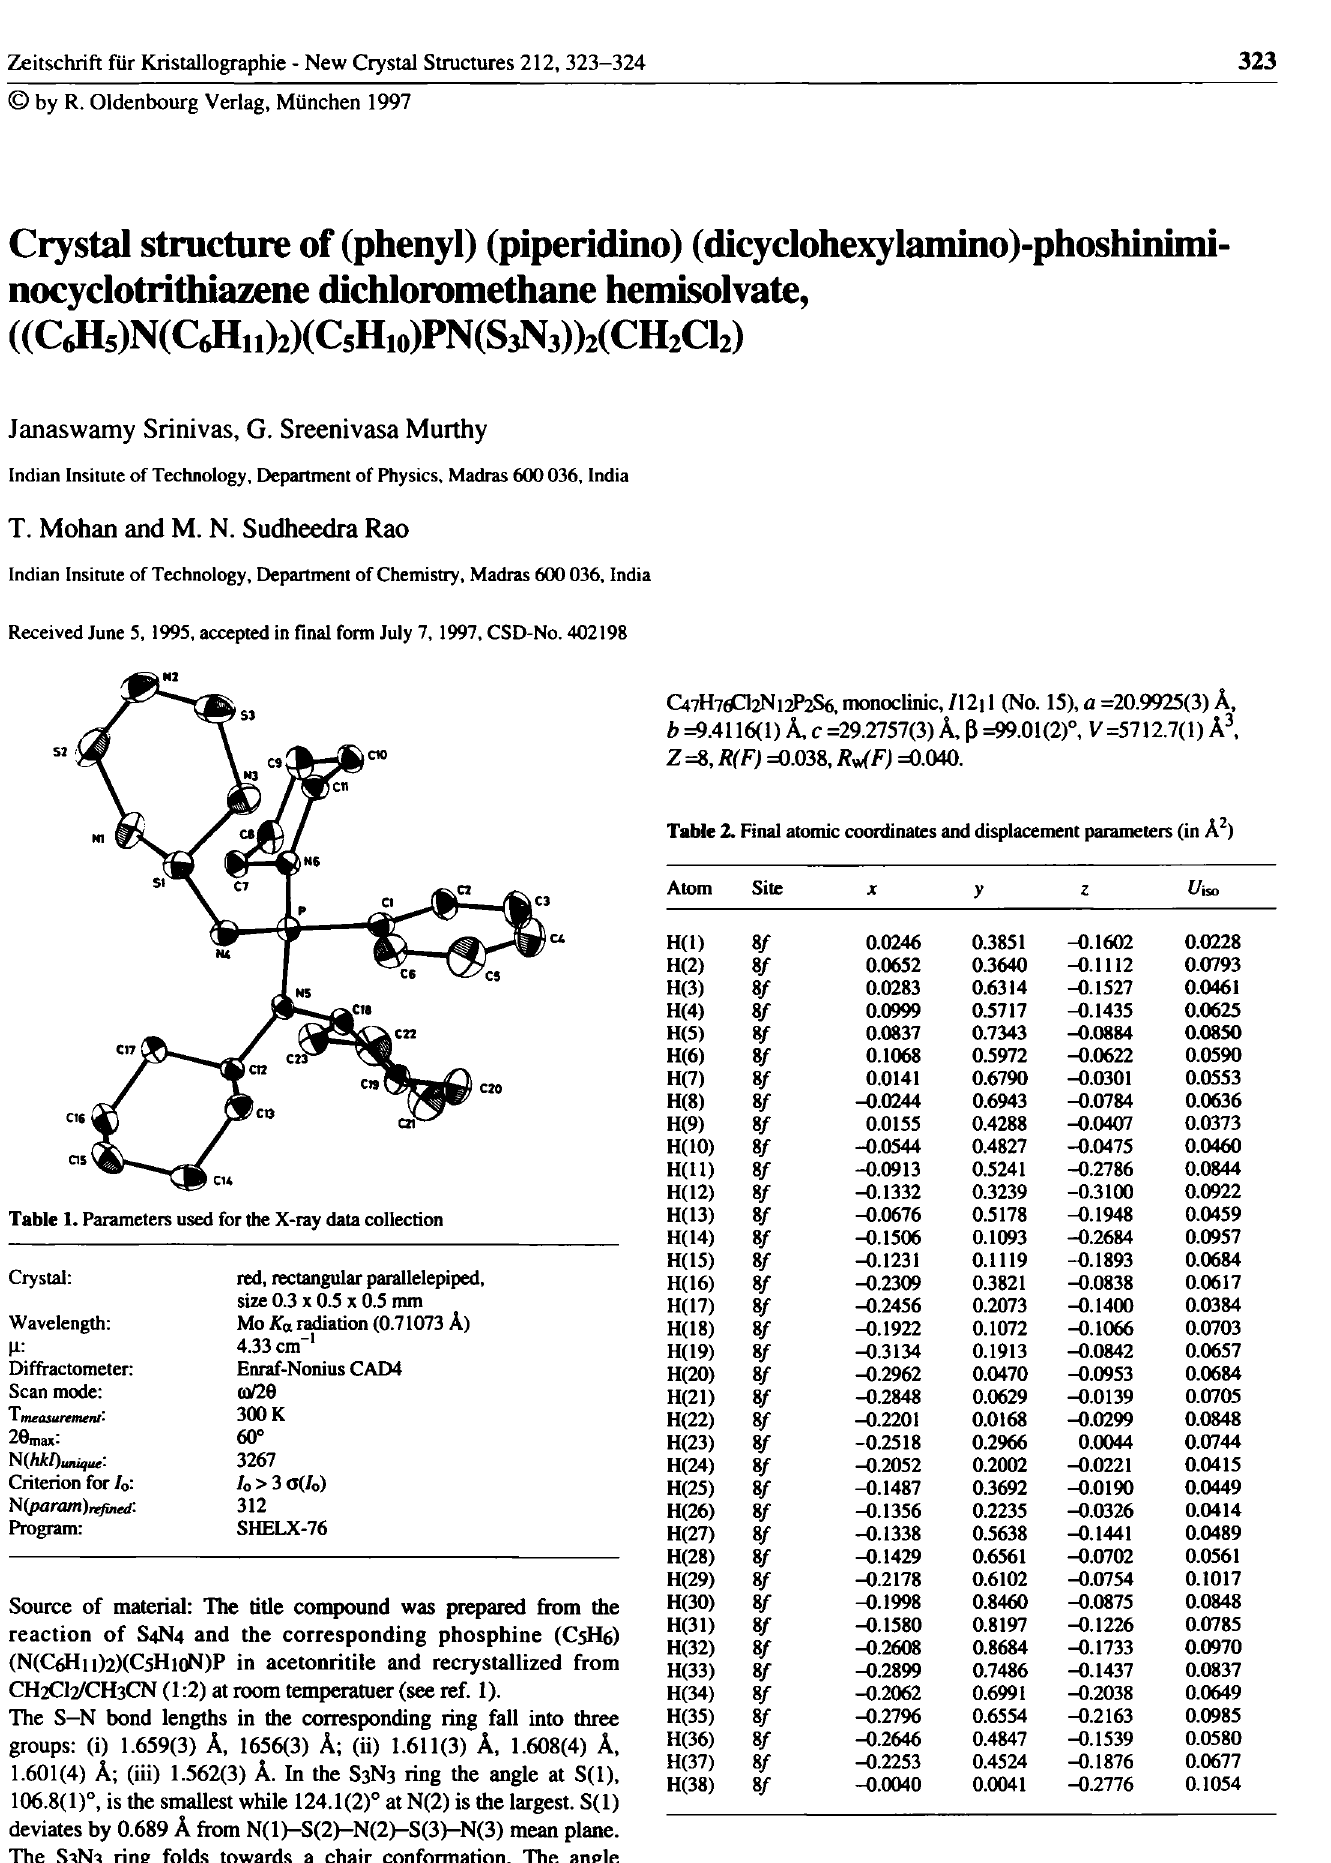
Table 1. Parameters used for the X-ray data collection Crystal: